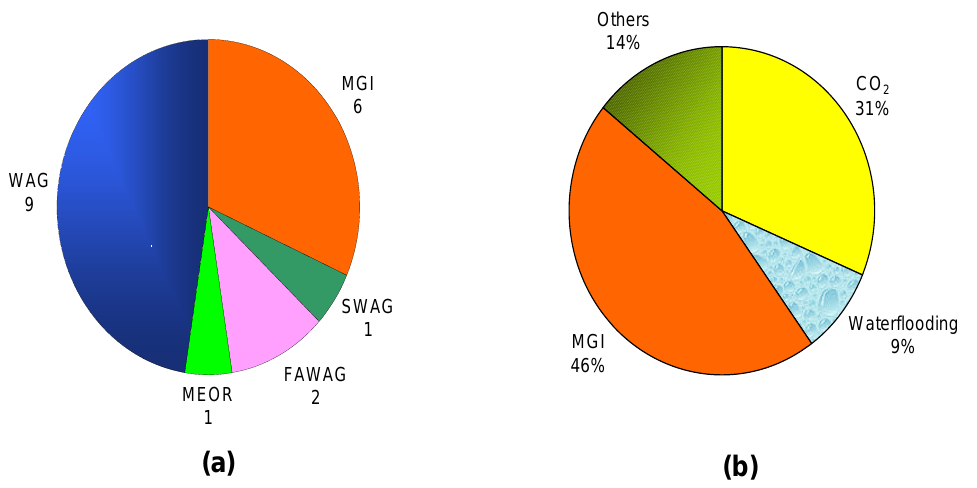
Figure 7. Examples of EOR in offshore fields: (a) North Sea EOR Projects (From Awan et al. , [262]) and, (b) EOR Opportunities Offshore Malaysia (From Samsudin et al. , [268]).